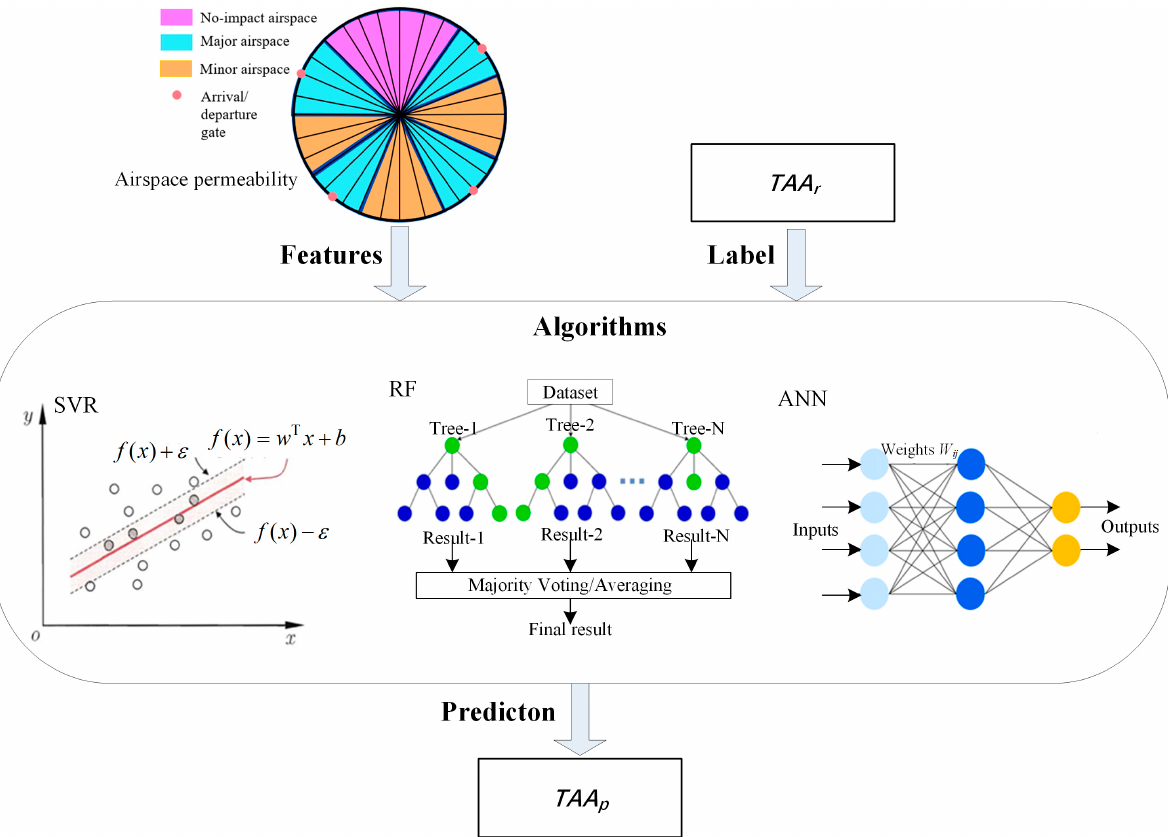
Figure 5. Schematic diagram of the training process of the availability rate prediction.